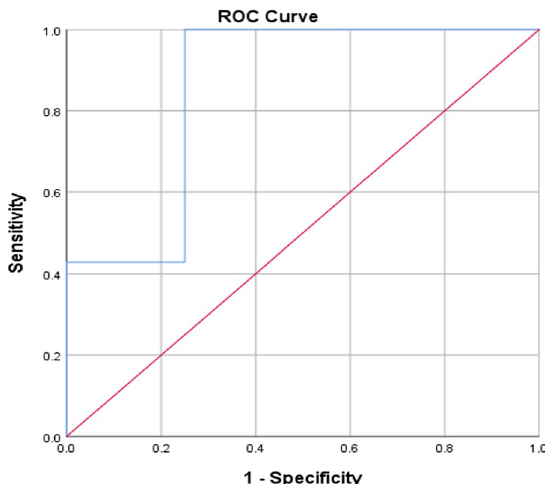
Fig. 3 ROC curve for ADC value in differentiation between benign and malignant cystic renal